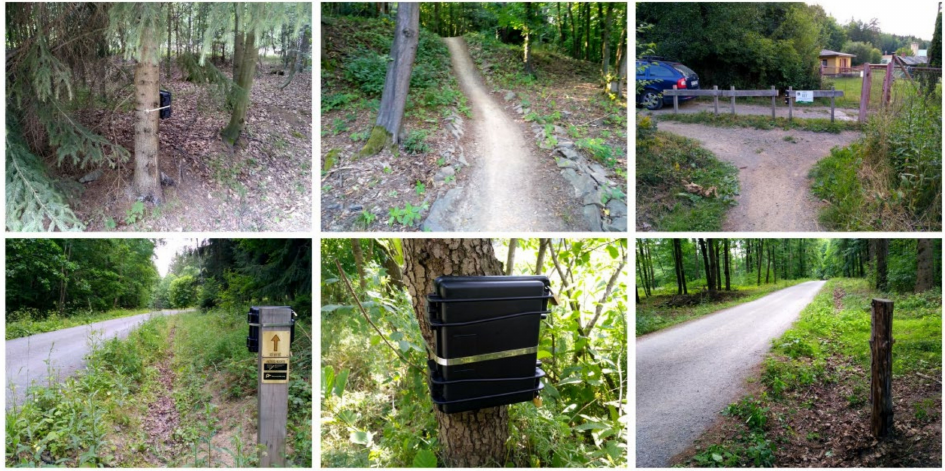
Figure 3. Examples of counter